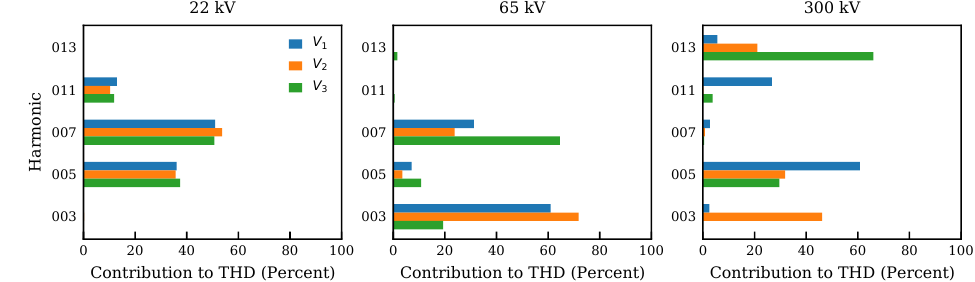
Figure 7. Total average contribution to THD over the period of one month per phase (columns) and site (rows). For each cycle, we calculate THD as well as each harmonics’ contribution to THD. We then average over all samples of January